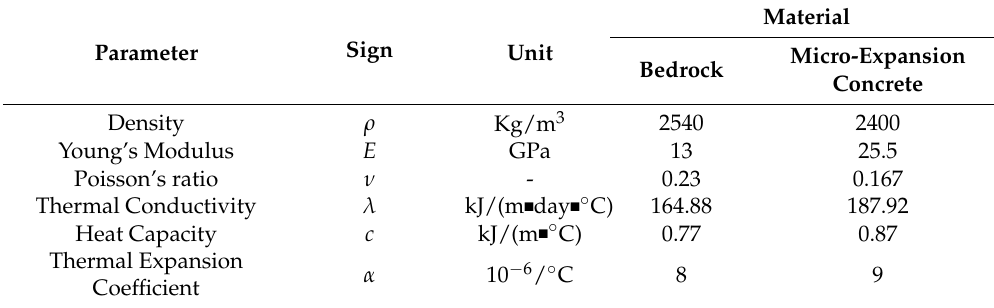
Table 4. Material parameters of the macro part of the multi-scale macro–meso